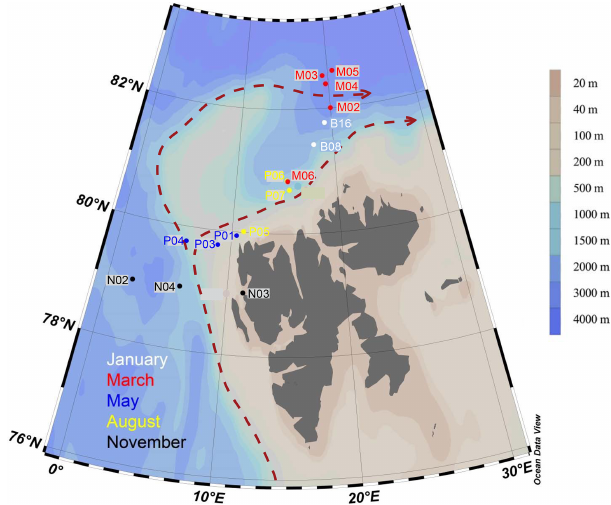
Figure 1. Map of sampling locations of the MicroPolar sampling campaign. Colors correspond to cruise month. The red dashed line indicates the major flow patterns of warm Atlantic water into the Arctic Ocean. The color scale bar indicates bottom depth. Red ar- rows indicate the main flow of the West Spitsbergen Current, ac- cording to Cokelet et al. (2008) and Randelhoff et al.